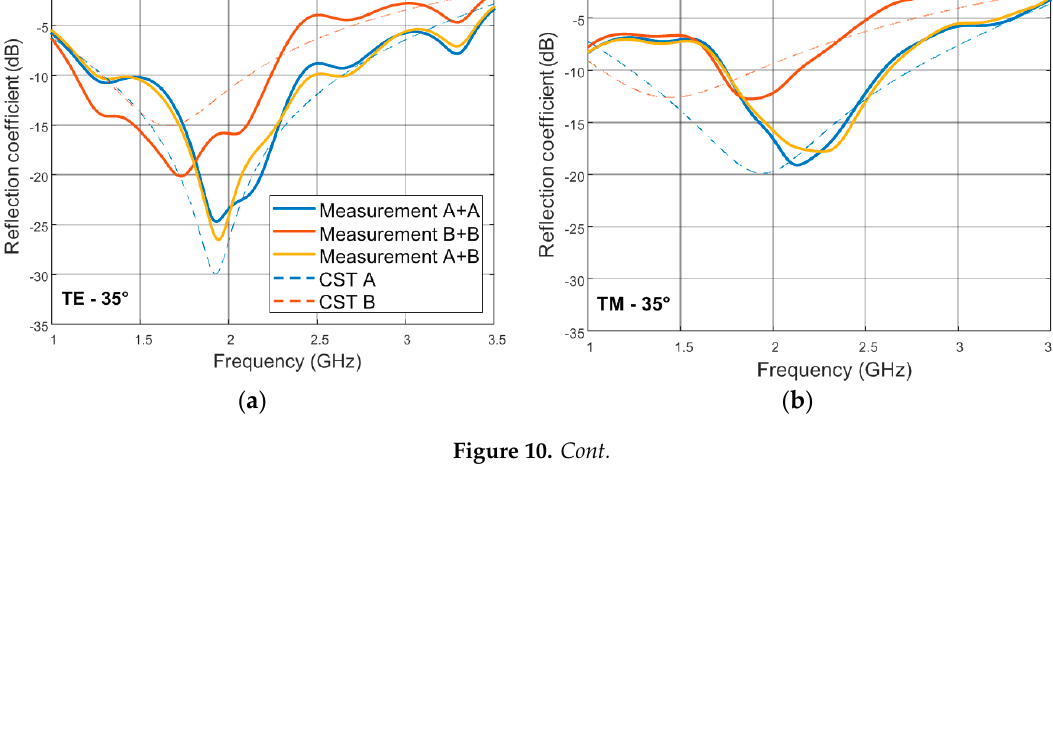
Figure 9. Picture of the measurement setup.